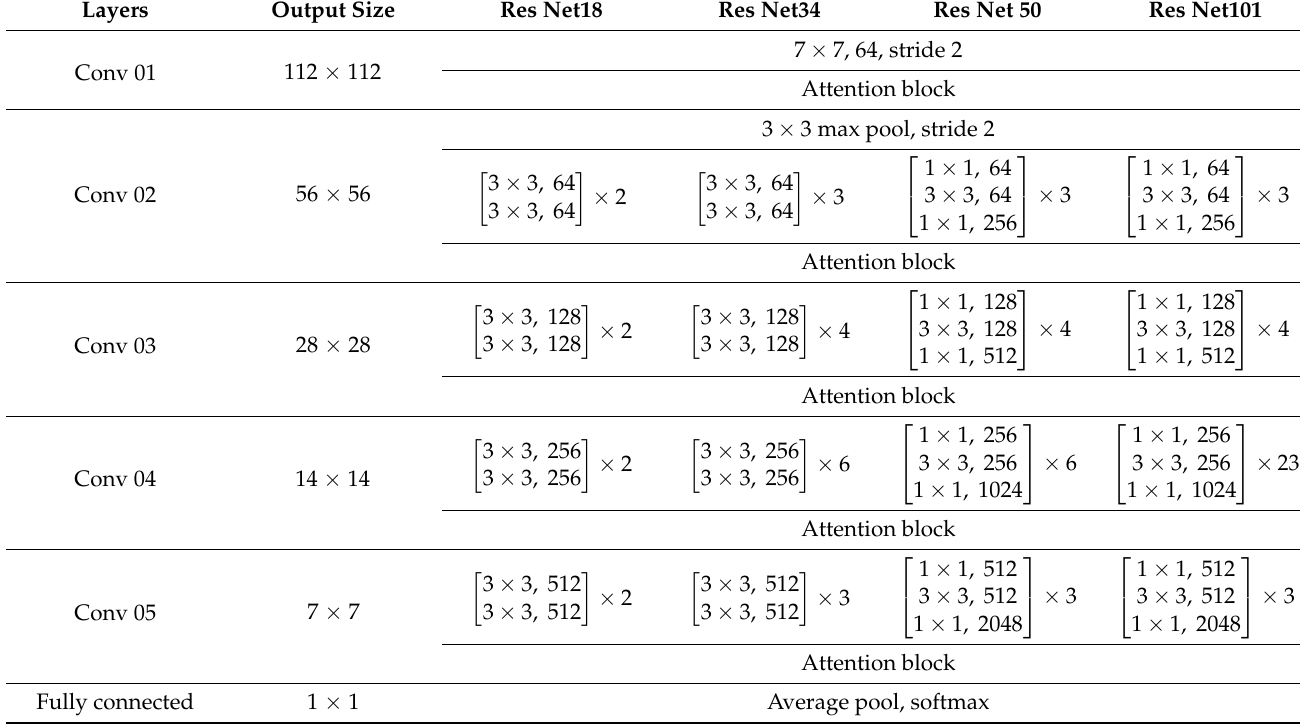
Table 2. Model structure setting and the insertion position of attention